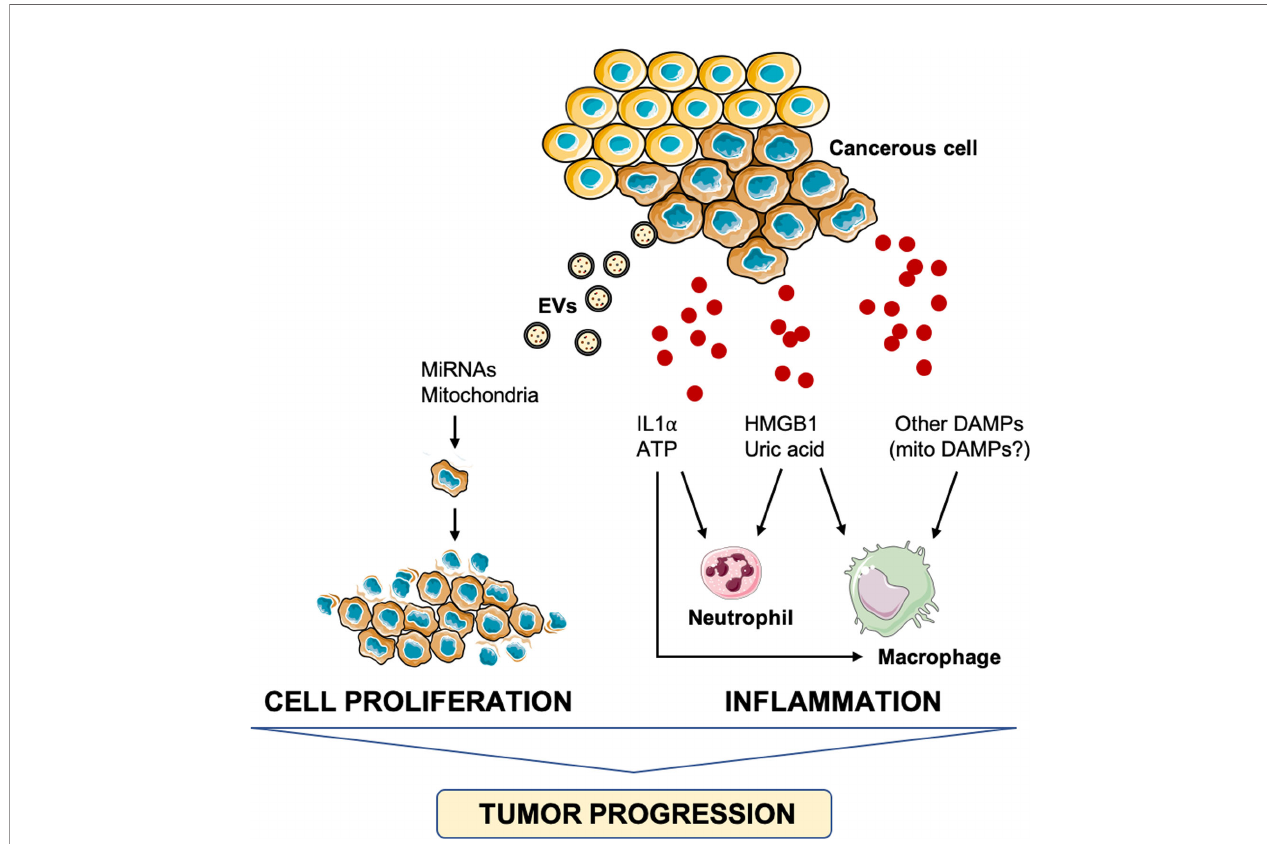
FIGURE 3 | Schematic representation of the main pathways triggered by damage-associated molecular patterns and involved in tumor progression. ATP, adenosine triphosphate; DAMPs, damage-associated molecular patterns; HMGB1, high-mobility group box 1, IL1 a , interleukin 1 a ; miRNA, micro